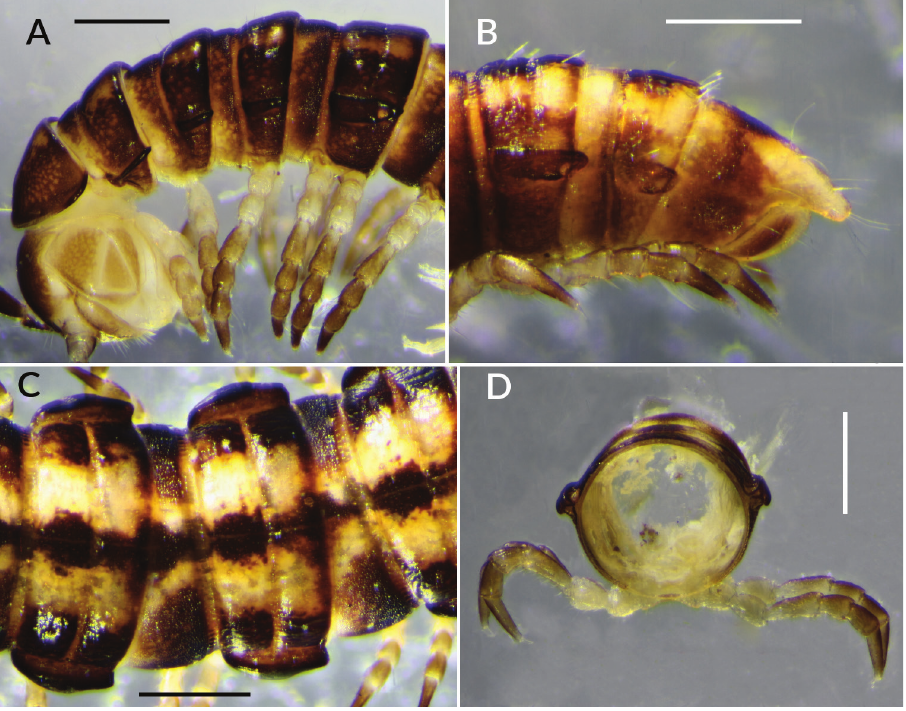
Figure 2. Tridactylogonus warrenbenensis sp. n. A Holotype (SAM OM2184), anterior end B Paratype male (ex SAM OM2185-OM2194), posterior end C Paratype female (ex SAM OM2185-OM2194), dorsal view of midbody rings D Paratype male (ex SAM OM2185-OM2194), posterior view of isolated midbody ring. Scale bars: 0.5